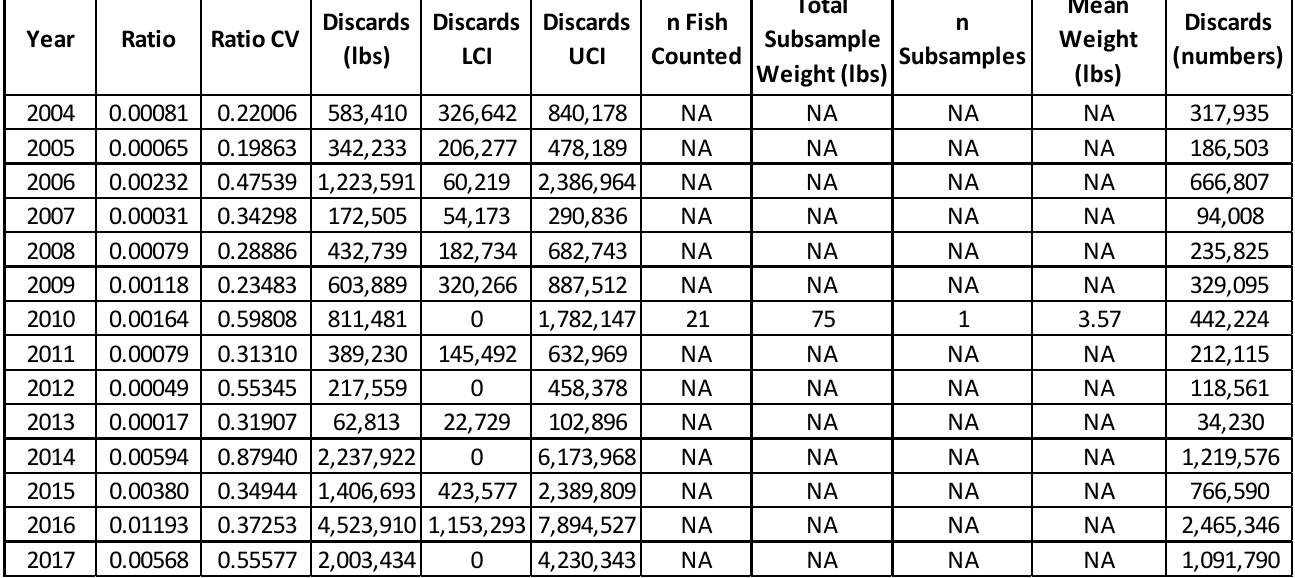
Table 30. Estimated horseshoe crab dredge discards in weight (lbs) and numbers. Data collected in 2010 was used to convert weight to discards in numbers for all years. To convert pounds (lbs) to numbers, a conversion of 1.8 pounds/crab was